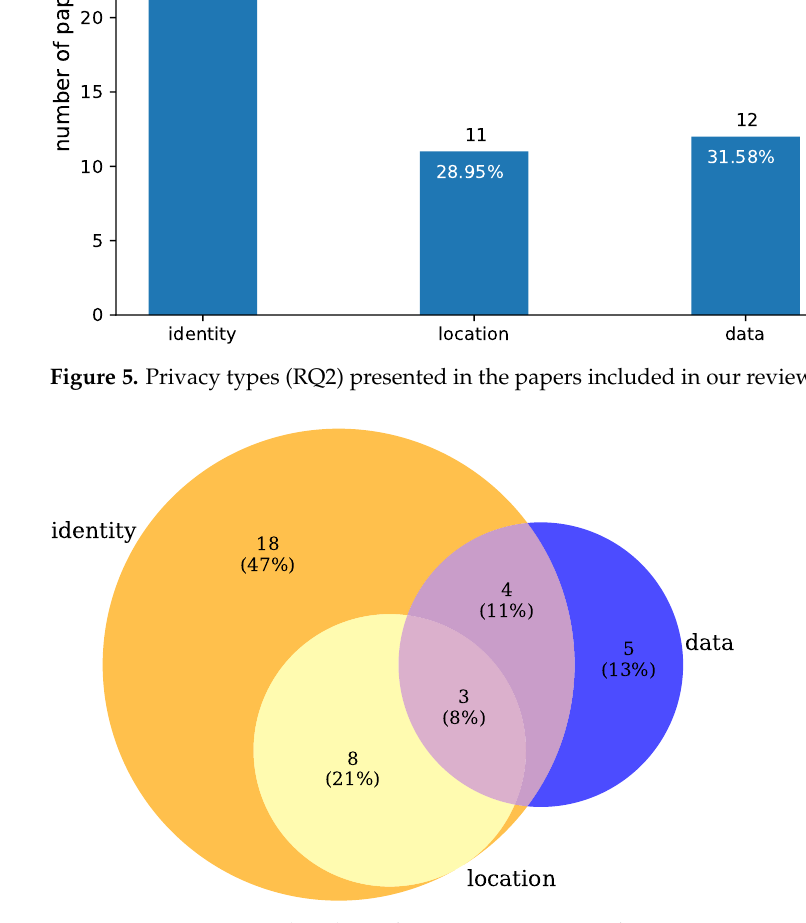
Figure 6. Privacy types (RQ2) overlapping using a Venn